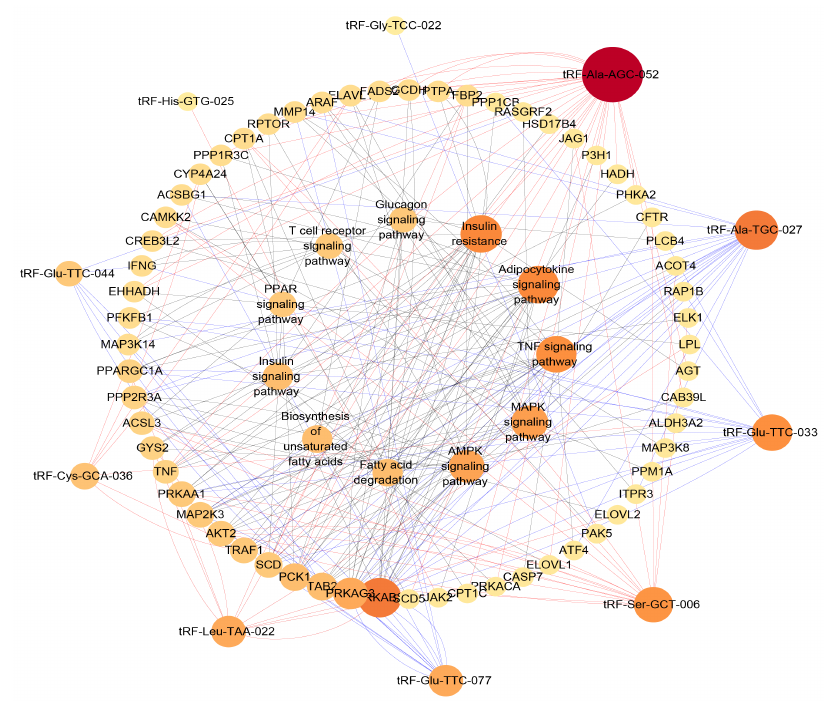
Figure 6. tsRNA-target gene-pathways network interactions. Diagram of the regulation network of tsRNA-target gene-fat development-related pathways. The red line indicates differential upregulation of tsRNA, the blue line indicates differential downregulation.